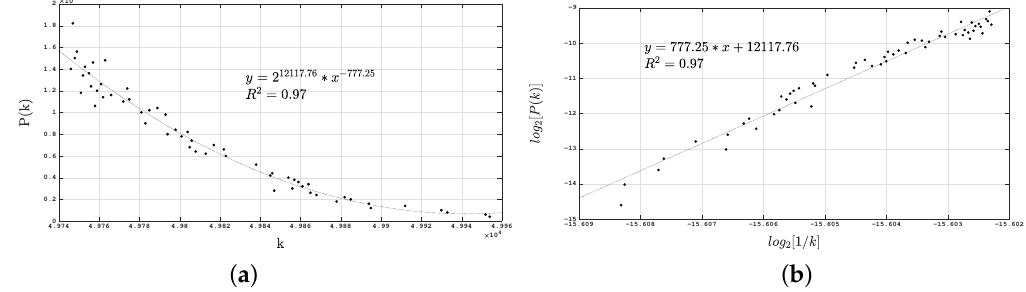
Figure 6. ( a ) P ( k ) vs. k plot and ( b ) log 2 [ P ( k )] vs. log 2 ( 1/ k ) plot generated from the 3D Visibility Graph for the data space [ y , z , x ] ss . R 2 is a statistical measure of fit that indicates how much variation of a dependent variable is explained by the independent variable(s) in a regression model.